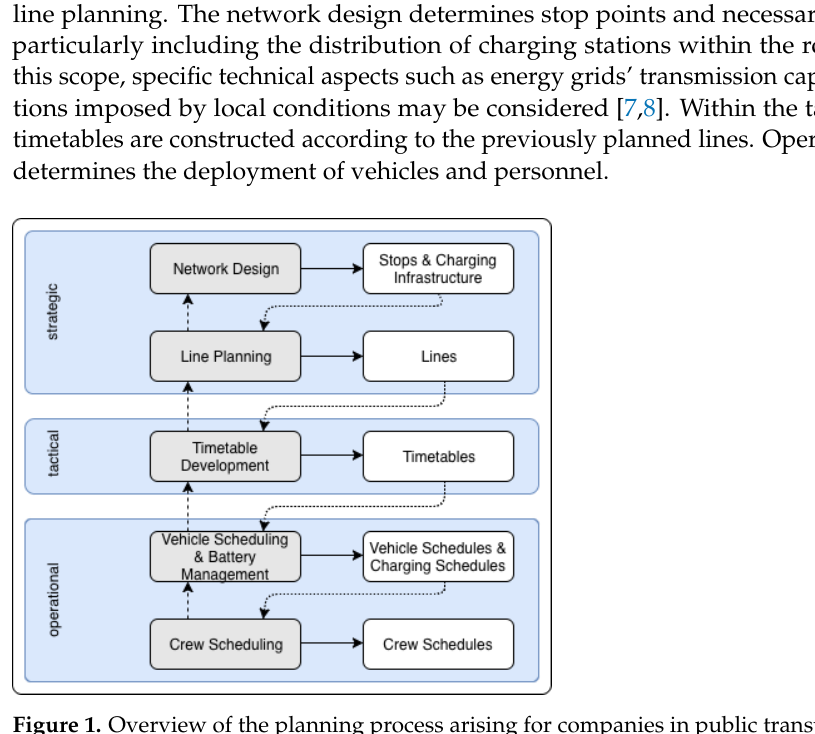
Figure 1. Overview of the planning process arising for companies in public transport when deploy- ing